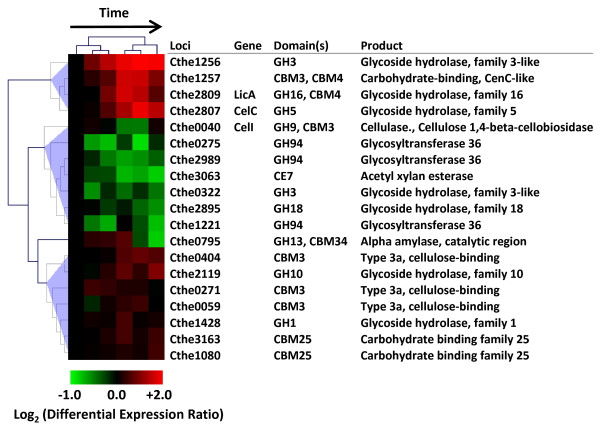
Non-cellulosomal genes differentially expressed during cellulose fermentation. Heat plot representation of Log2 (Differential Expression Ratio) and hierarchical clustering of non-cellulosomal CAZyme genes showing statistically significant differences in transcript expression over the course of Avicel® fermentation by Clostridium thermocellum ATCC 27405. Domain key: GH = Glycoside Hydrolase, CE = Carbohydrate Esterase, PL = Polysaccharide Lyase, CBM = Carbohydrate Binding Module, Unk = unknown, based on the Carbohydrate Active Enzymes database (http://www.cazy.org; [41])